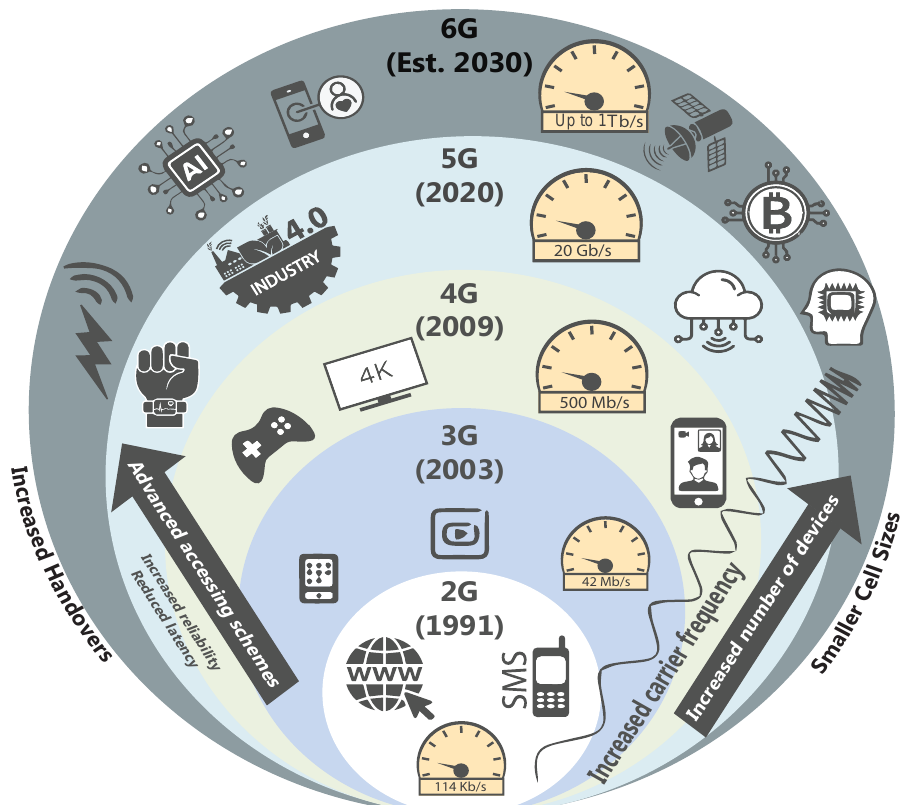
Figure 1. Mobile Cellular Generations with their Applications. The small cell base stations (BS) are defined as low-power nodes that cover a limited range of up to a few hundred meters. These BSs can also operate independently or in conjunction with the macro cell [8,9]. mmWave communication and network densification have greatly enhanced bandwidth, capacity, and data rate, as well as QoS, but at the expense of mobility management and handovers (HO). Because both concepts rely on the idea of small cells with a relatively limited coverage footprint, resulting in more frequent HOs.